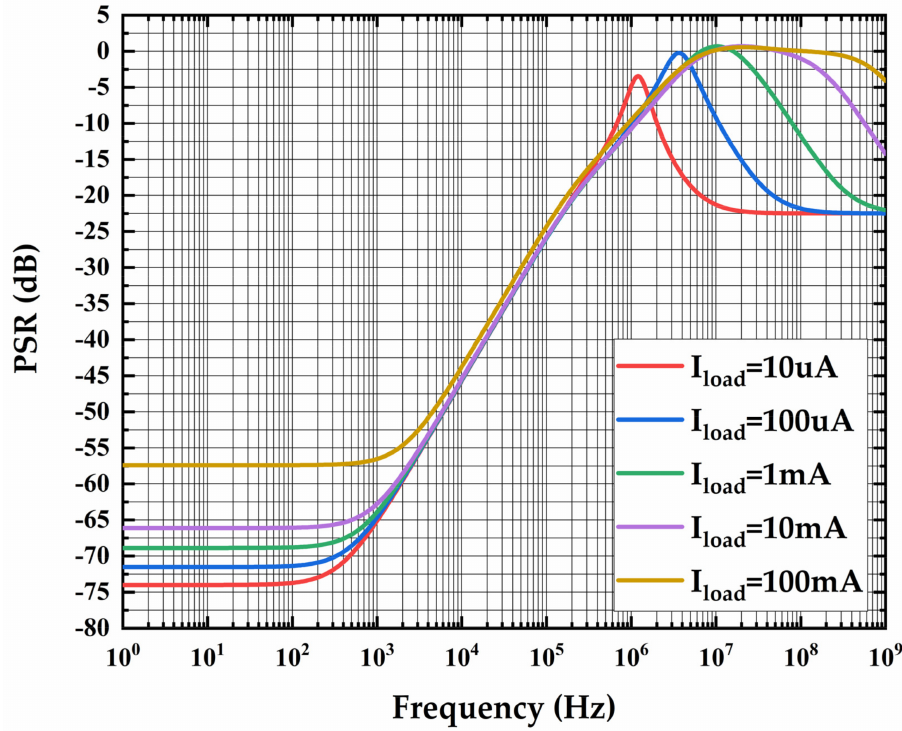
Figure 12. Simulated PSR versus frequency under different load currents when V IN = 1.2 V, V out = 1.0